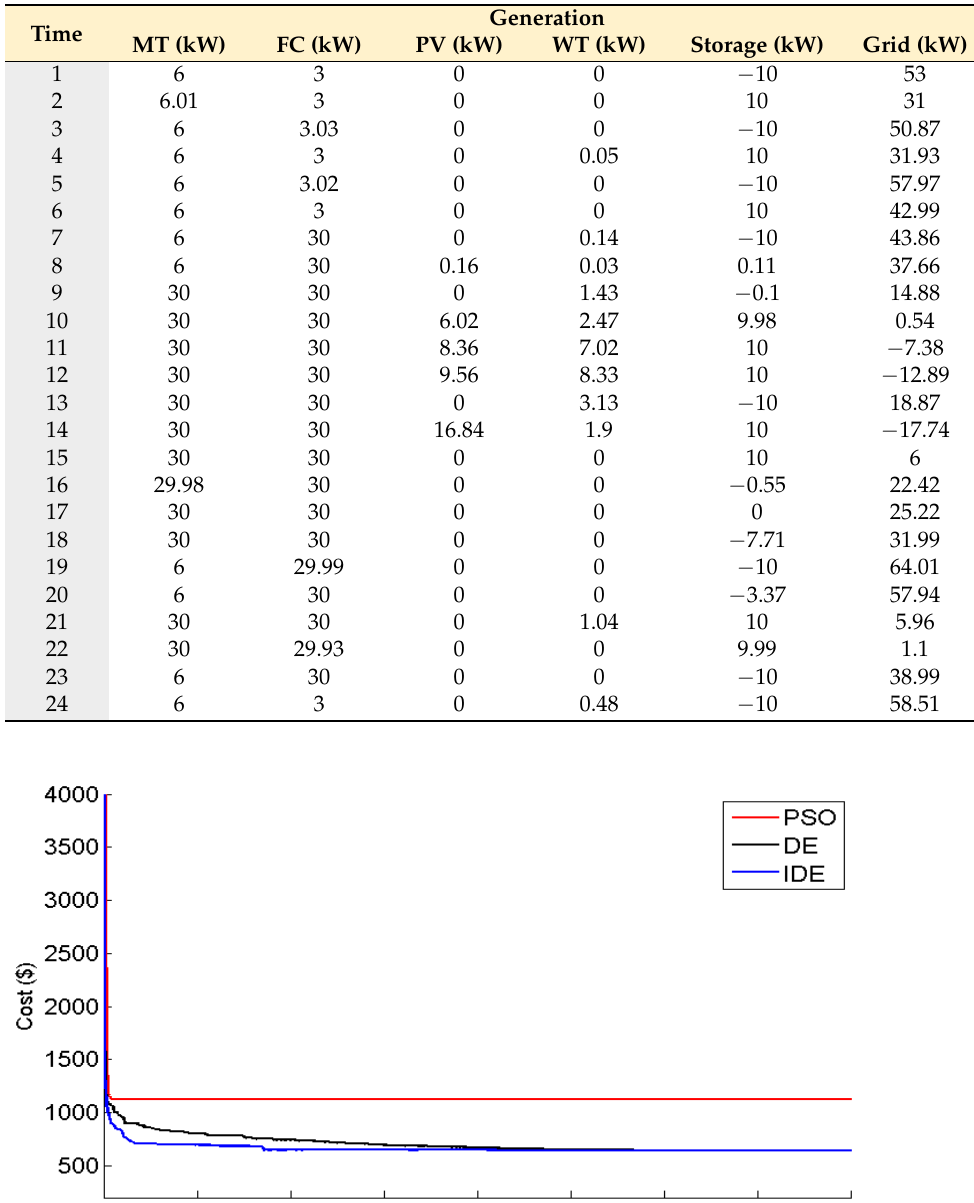
Table 5. Distributing power to reduce costs without considering the limitations of upstream network power exchange.